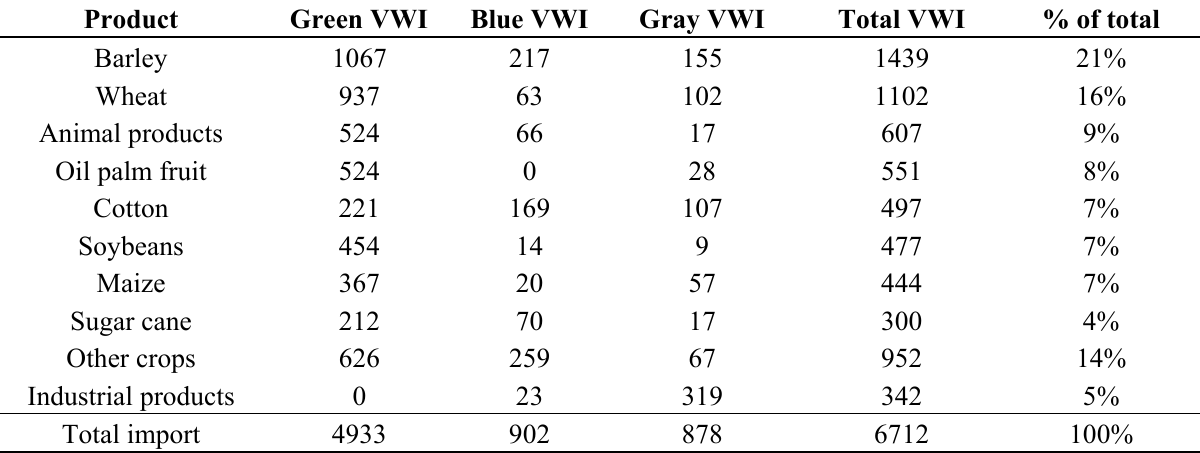
Table 5. Jordan’s virtual water import (VWI) by major product (10 6 m³/year). Period: 1996–2005. Data based on [8].